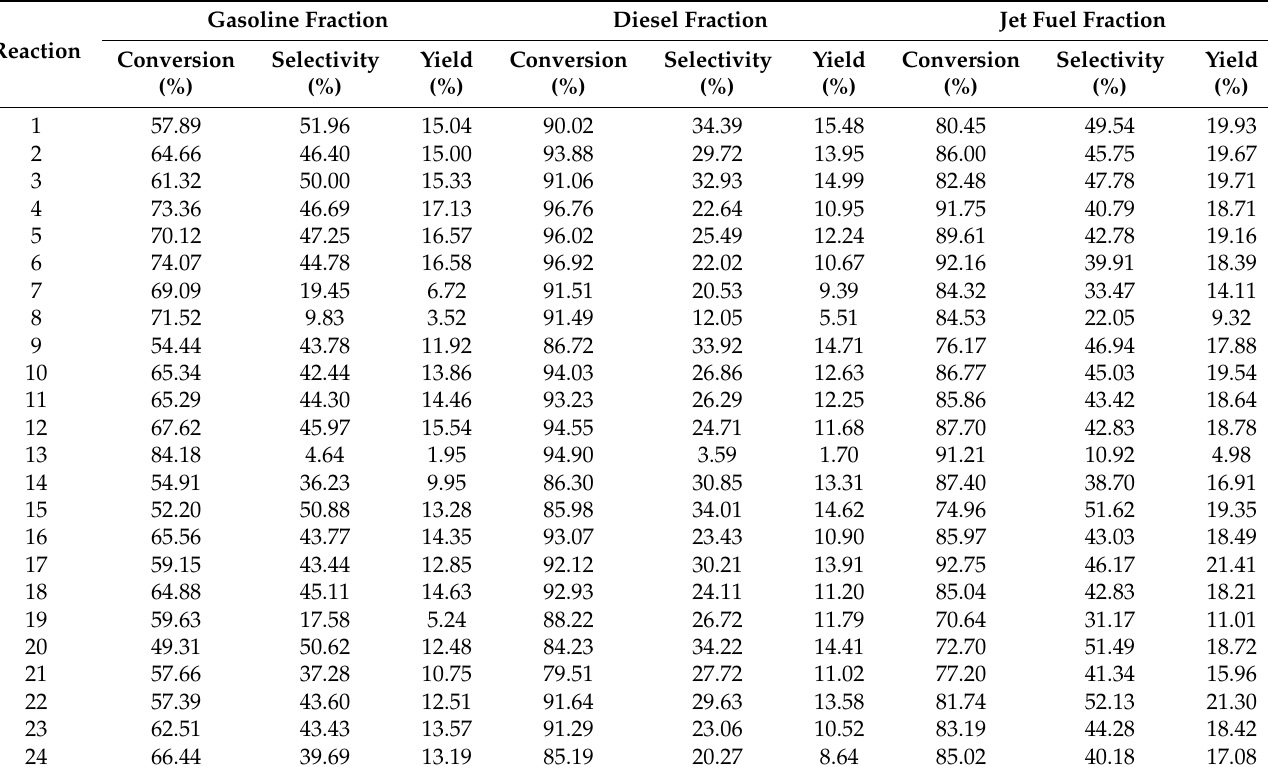
Table 4. Conversion, selectivity, and yield of hydrocracking standard